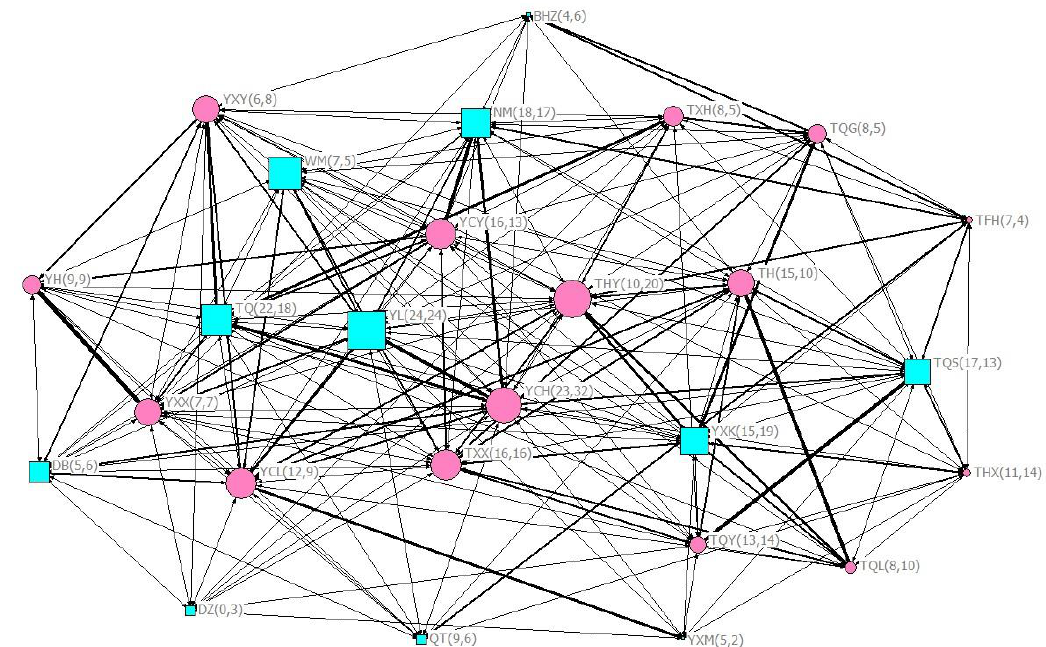
Figure 2. Eigenvector centrality coefficients of group members in the social network. Nodes represent all individuals in the group; males and females are respectively shown in blue squares and orange circles; node size is directly proportional to centralities; line thickness represents members’ association index in the social network; the letters on labels represent the name of each individual, and the number after each individual’s name represents the times it has become expresser and observer, respectively. Table 2. Results of GLMM (family = Poisson) used to test the factors affecting the scratch contagion.